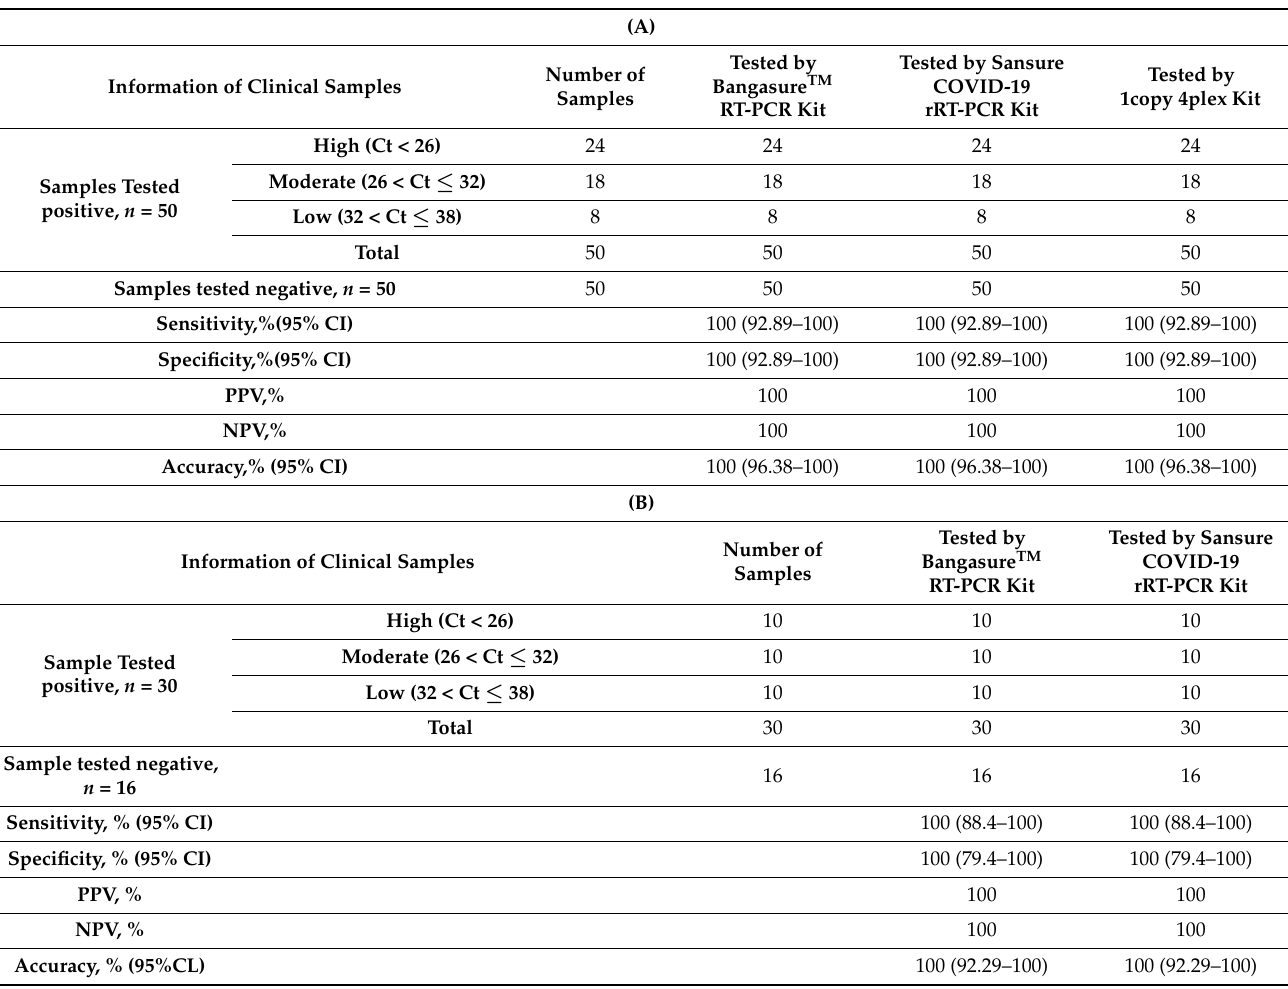
Table 3. Validation and performance determination of the Bangasure TM RT-PCR kit against